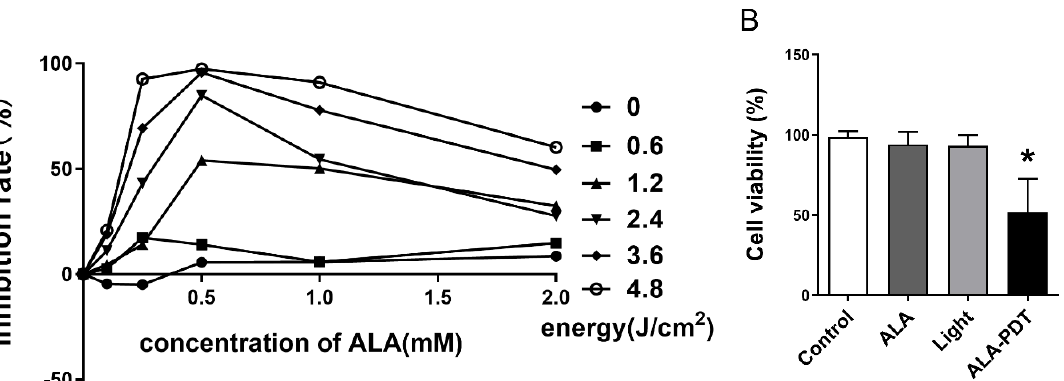
Figure 1. ALA-PDT inhibited the proliferation of HeLa cells. ( A ) Inhibitory effects of different gradients of ALA and laser irradiation energy on HeLa cells. ( B ) Inhibition rate of HeLa cells with 0.5 mM ALA and 1.2 J/cm 2 light energy. * p < 0.05 compared with the control group.